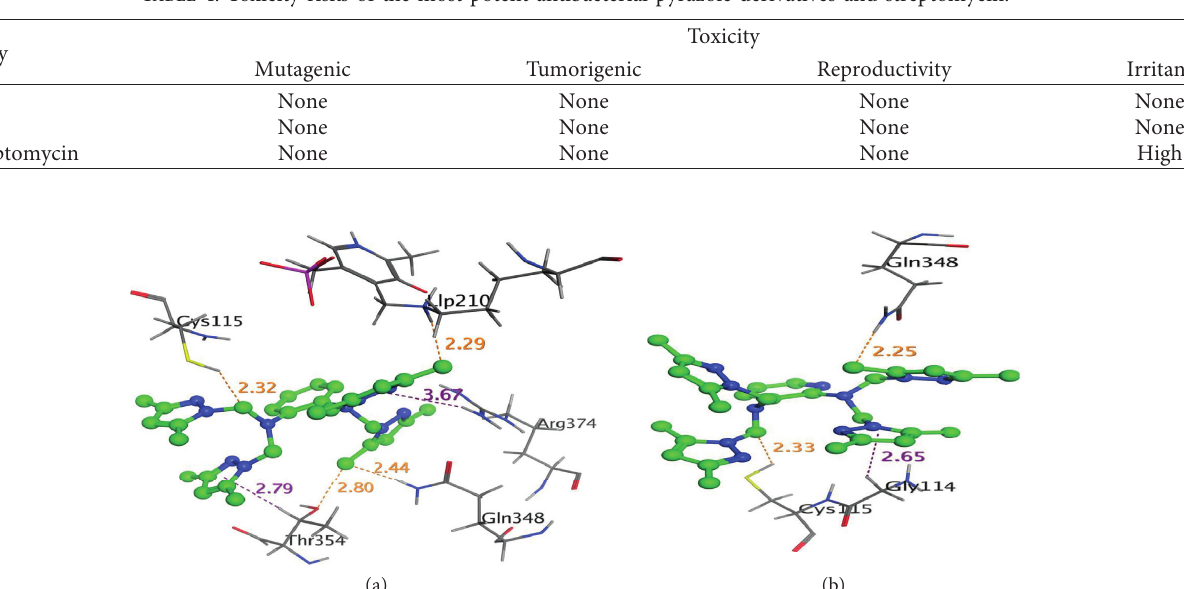
Table 4: Toxicity risks of the most potent antibacterial pyrazole derivatives and streptomycin.